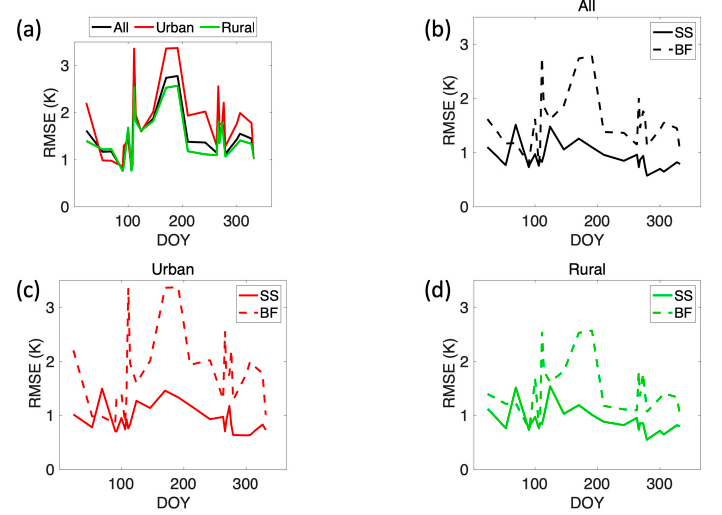
Figure 15. Comparison of accuracy between bilateral filtering (BF) and scale-separating (SS) framework. ( a ) RMSE for BF. ( b – d ): comparison between BF and SS for the entire scene, urban areas, and rural areas.